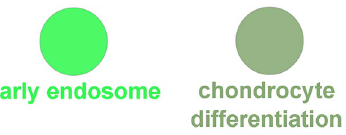
Figure 8. Results for enrichment analysis for target genes of gga-miR-1652: GO networks and Kappa score groups of GOs.